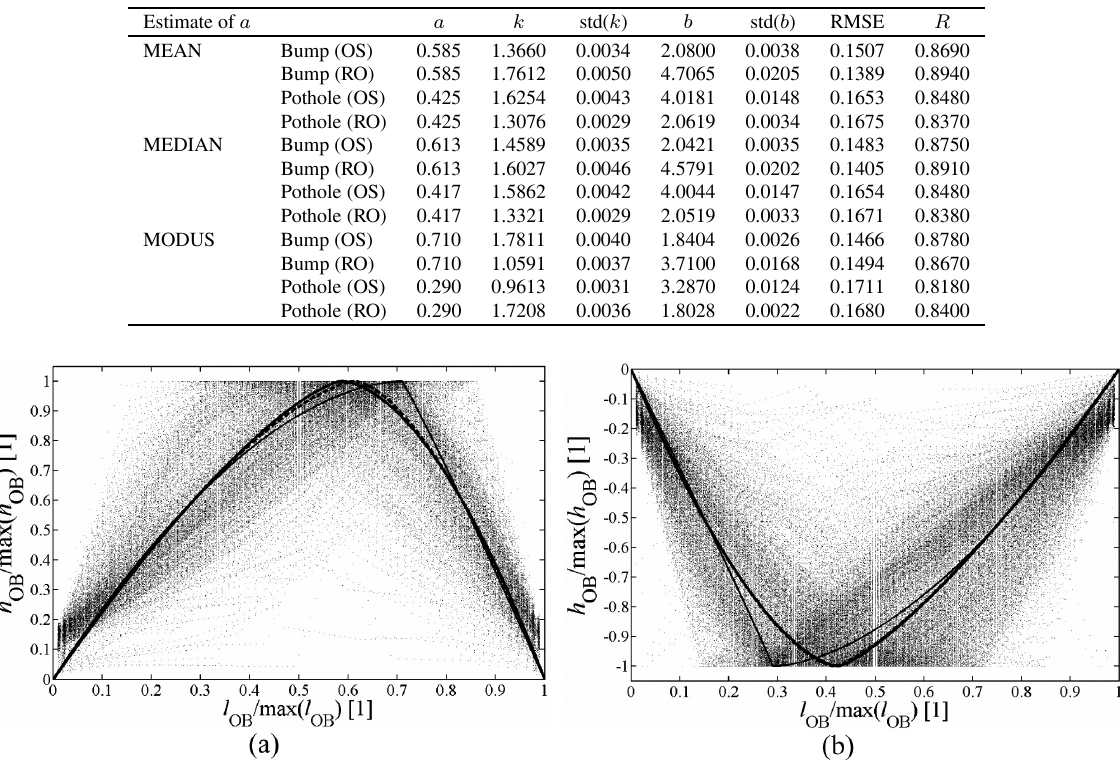
Table 4 Fitting parameters of asymmetric obstacle shapes power( k OS , k RO ) to real CC pavements separately